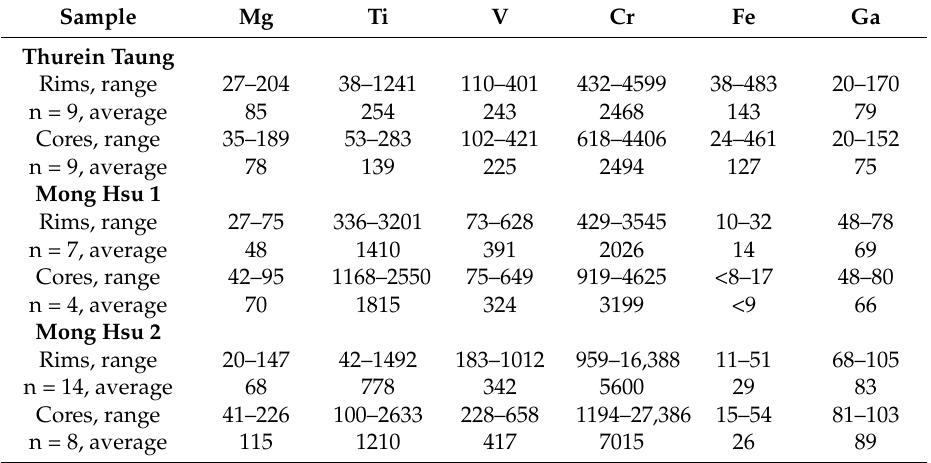
Table 1. Trace element comparative ranges and averages (ppm), Myanmar ruby